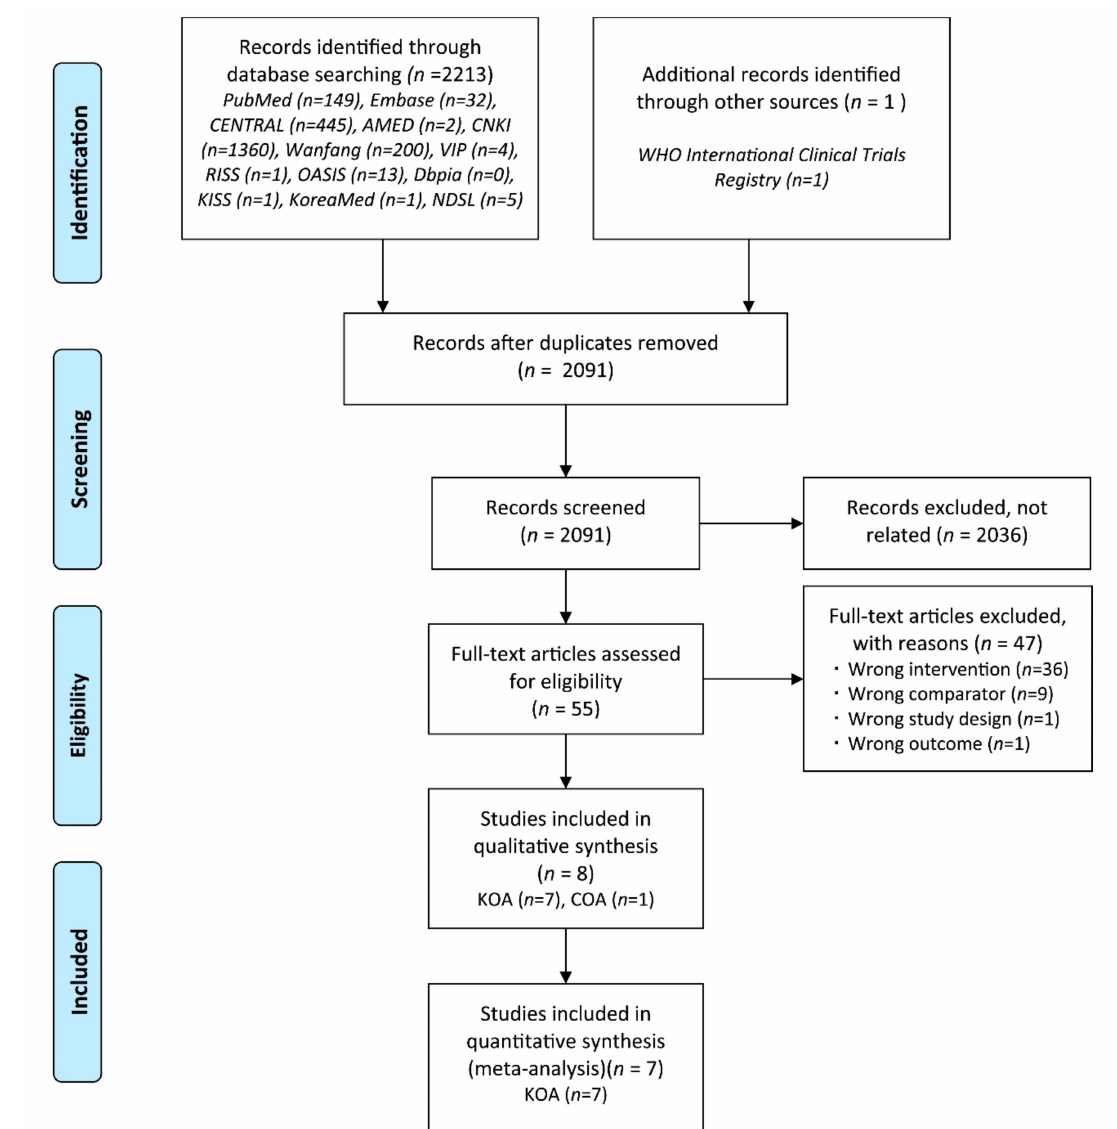
Figure 1. Study selection process. COA: cervical osteoarthritis, KOA: knee